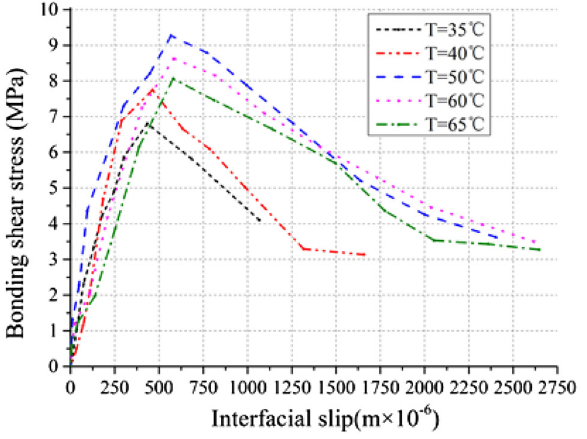
Fig. 12 Bond–slip of loading end at different